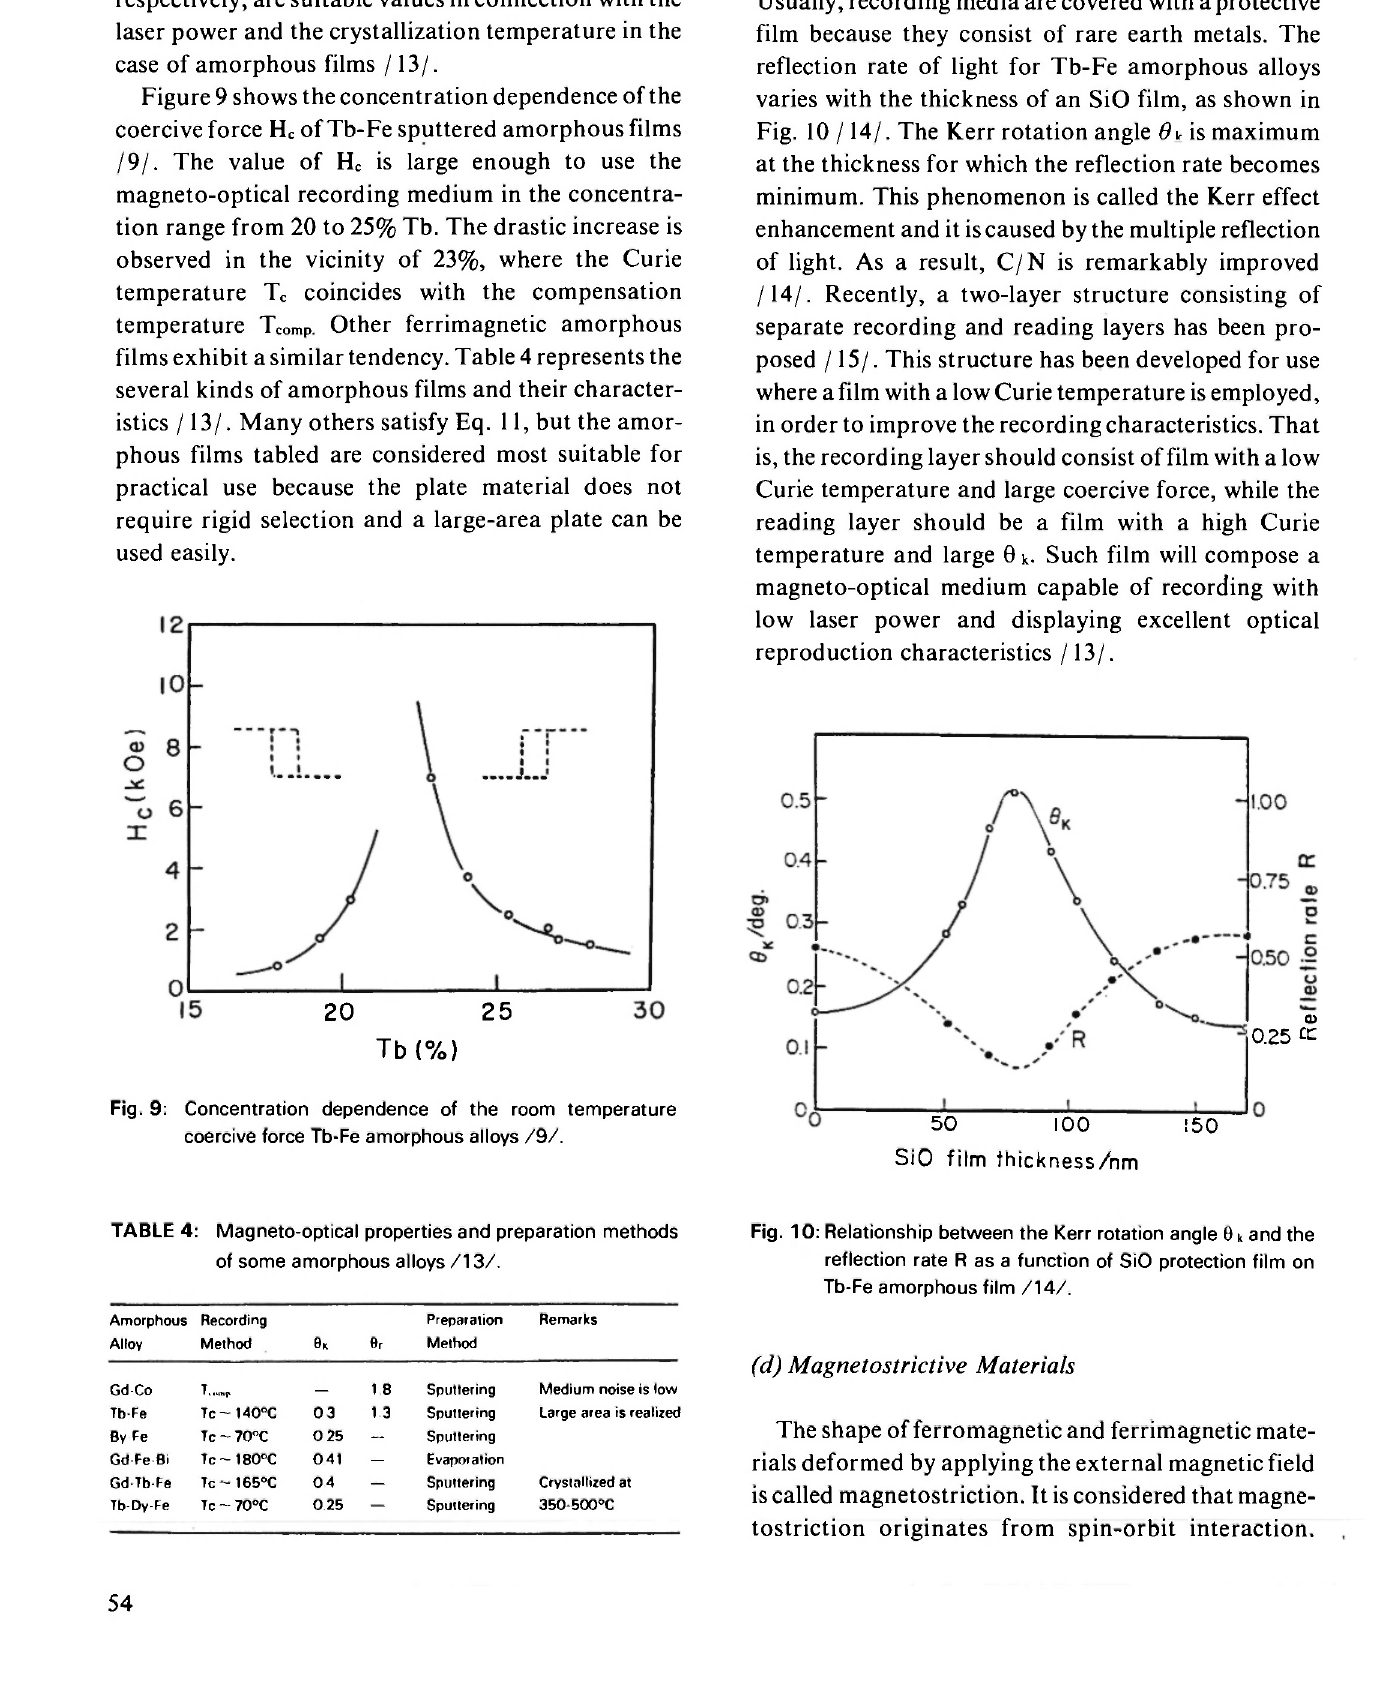
Fig. 10: Relationship between the Kerr rotation angle θ ι and the reflection rate R as a function of SiO protection film on Tb-Fe amorphous film